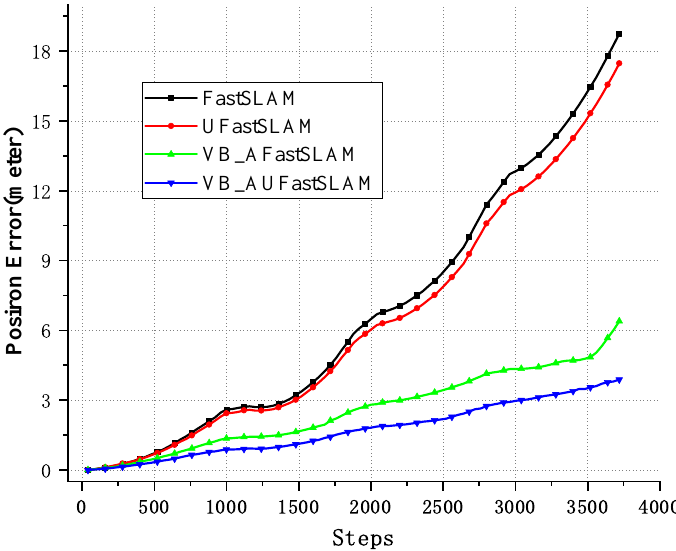
Figure 5. n = 2; p = 0.3, algorithms error